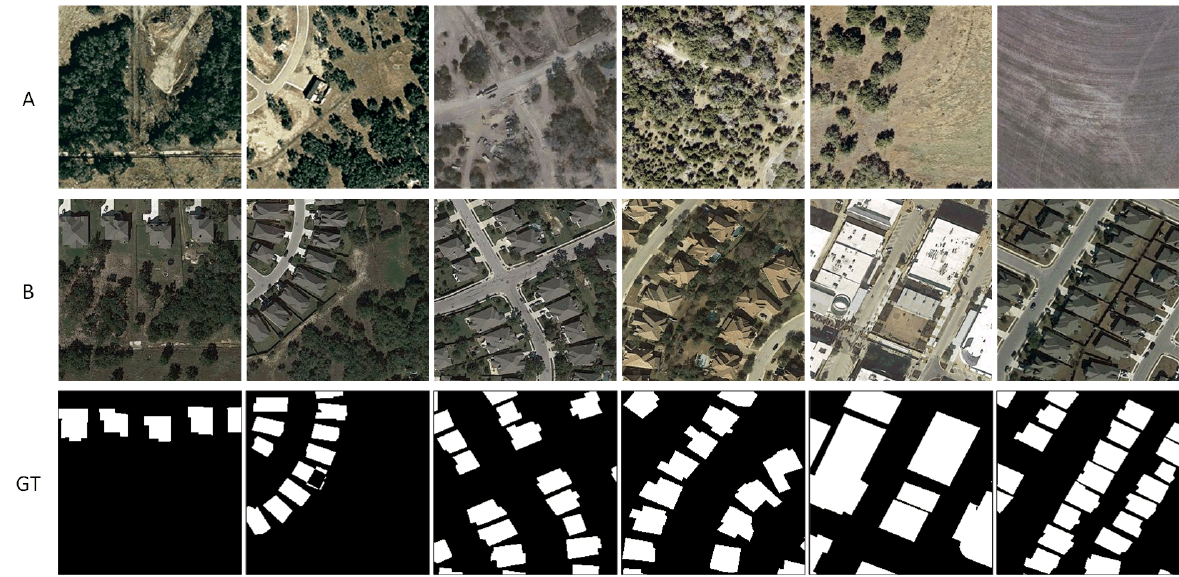
Figure 5. Illustration of samples from LEVIR-CD. (A) and (B) indicate the bi-temporal image pairs. (GT) indicates the